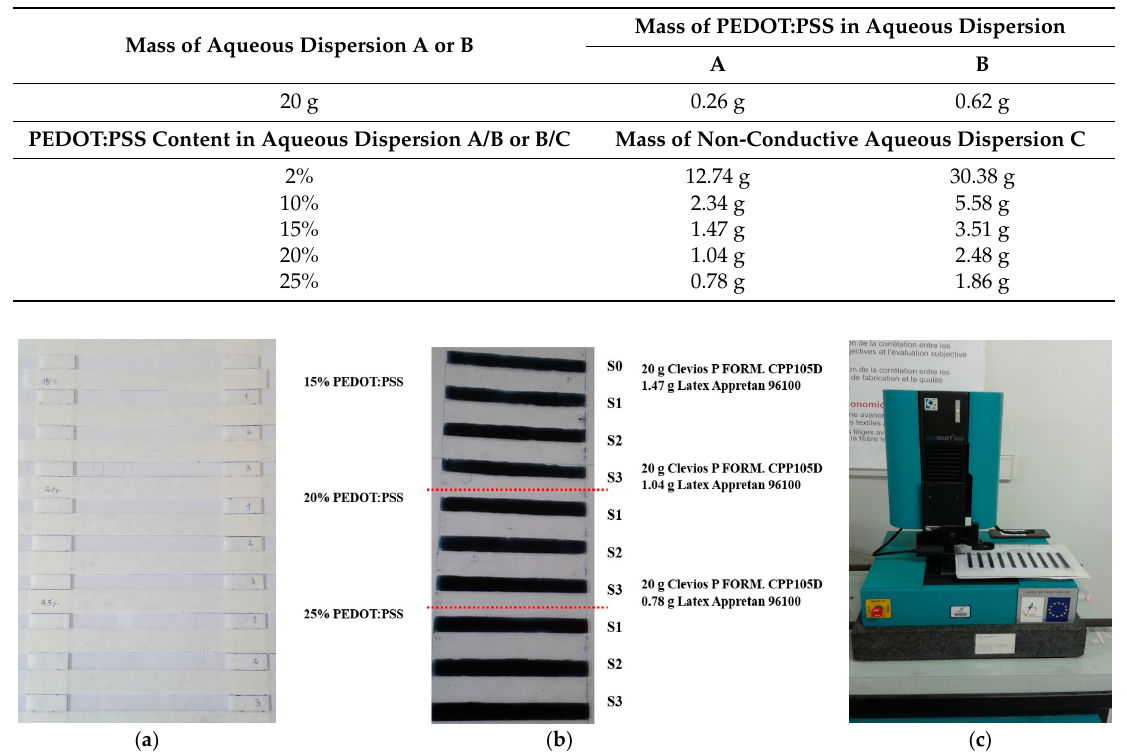
Figure 1. Conductive polymer films preparation for percolation threshold study: ( a ) frame preparation; ( b ) dry PEDOT:PSS films; ( c ) optical